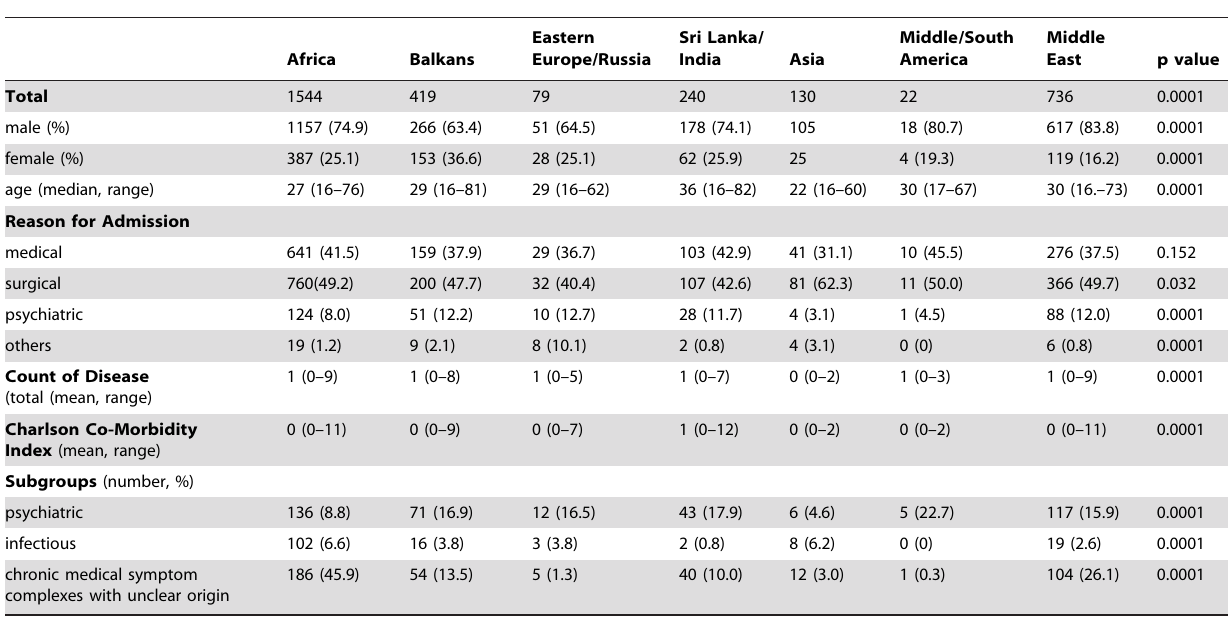
Table 3. Overview of reasons for admission and multimorbidity in relation to geographical